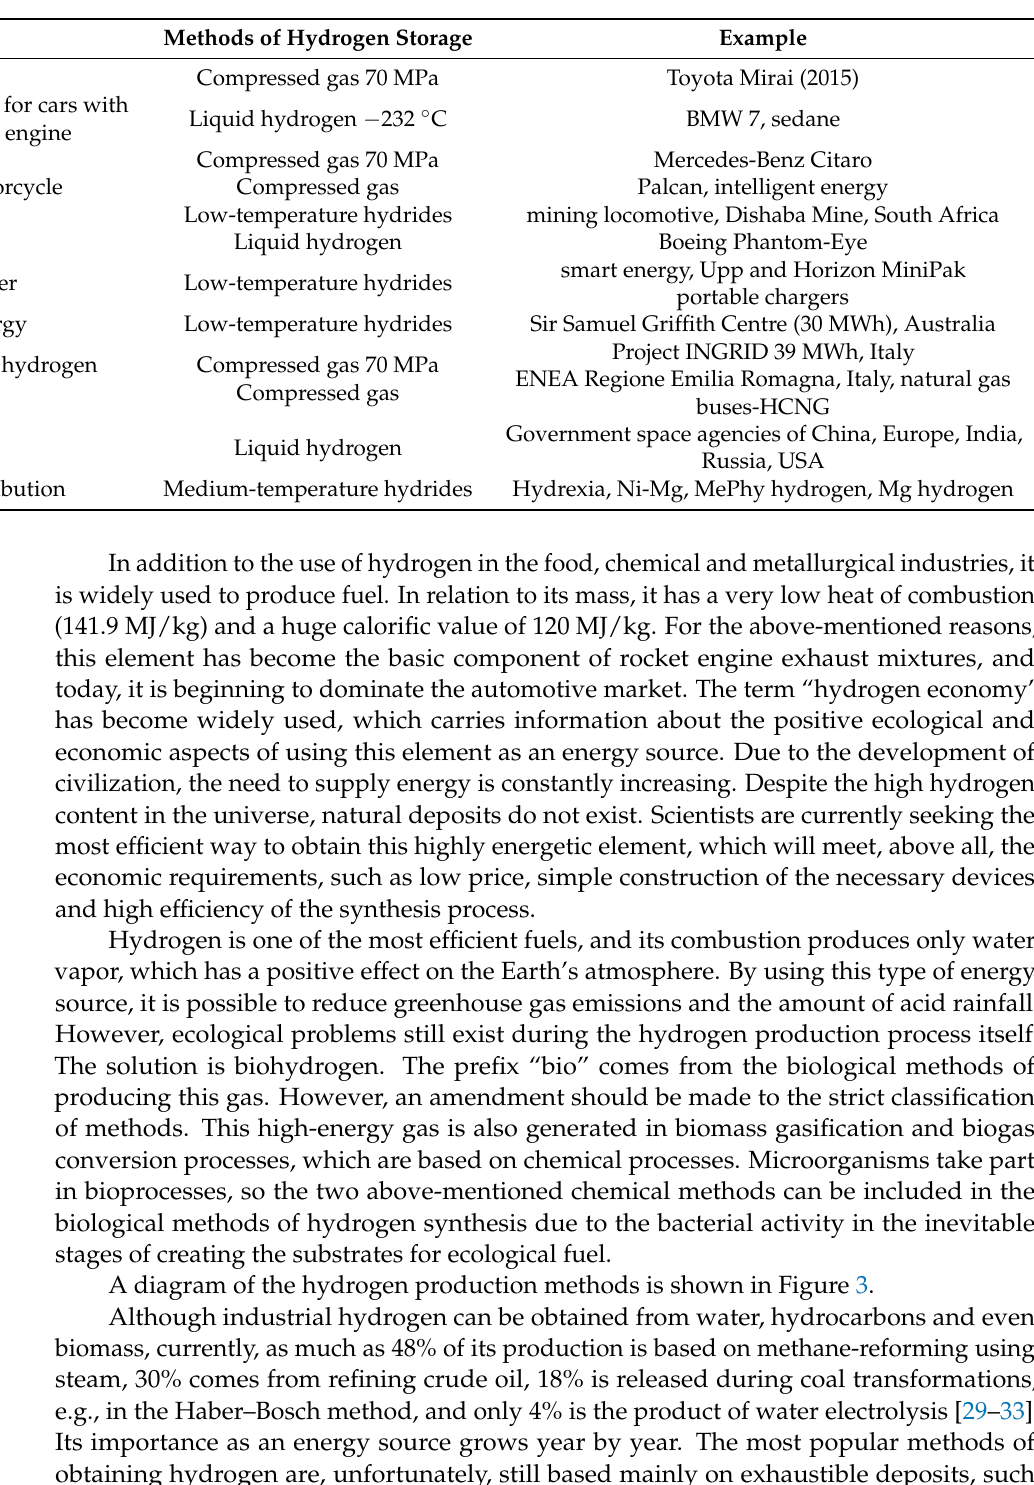
Table 2. The occurrence of hydrogen in various